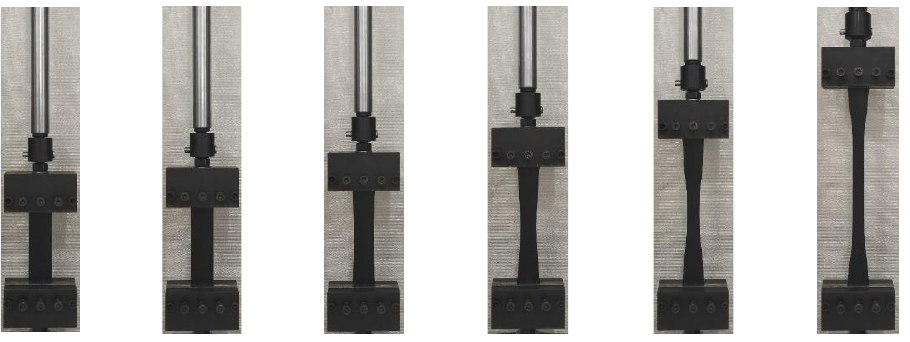
Figure 4. The tension process of a HDPE specimen. The HDPE specimen fractures during a tension at − 35 ◦ C, as shown in Figure 6. The fracture mode of HDPE I and II specimens is similar and belongs to the ductile tearing failure. When a certain stress is reached, a small crack begins to appear on one side of the specimen. With an increase in displacement, the crack expands rapidly along the direction perpendicular to the axial force until the specimen is